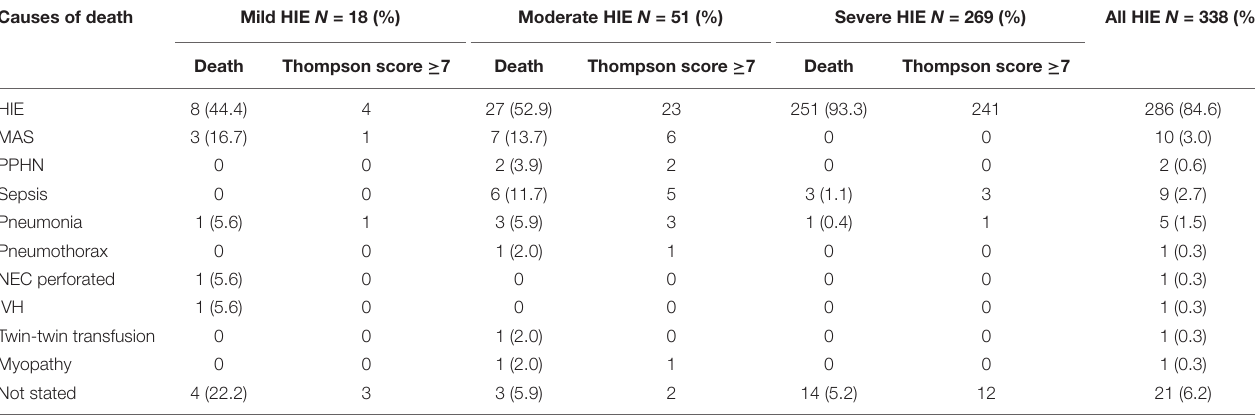
TABLE 4 | Causes of death of hypoxic-ischemic encephalopathy according to the severity. Causes of death Mild HIE N = 18 (%) Moderate HIE N = 51 (%) Severe HIE N = 269